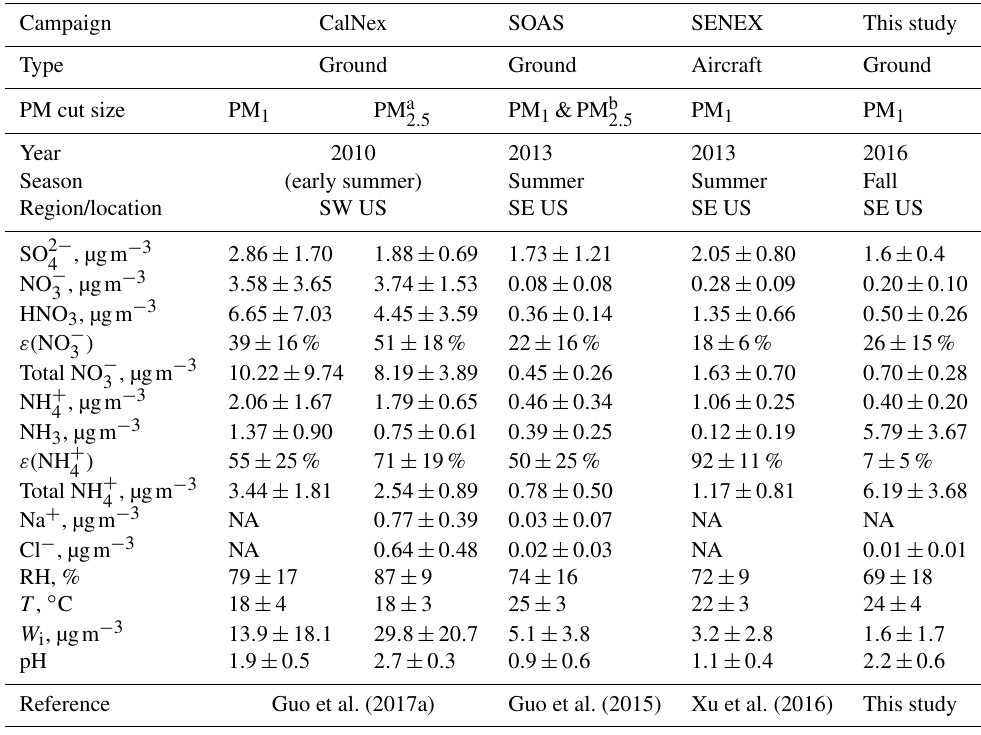
Table 1. Comparisons among different field campaigns for particle pH, major inorganic ions and gases, and meteorological conditions. All pH values were calculated using ISORROPIA II run in forward mode. These statistics were previously compiled by Guo et al. (2017a). Campaign acronyms used here stand for the California Research at the Nexus of Air Quality and Climate Change (CalNex), Southern Oxidant and Aerosol Study (SOAS), and Southeastern Nexus of Air Quality and Climate (SENEX).